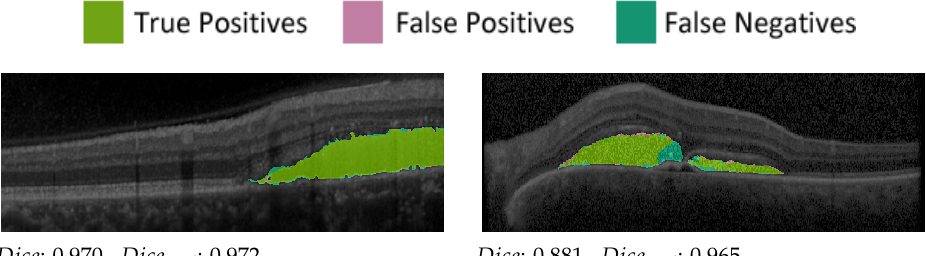
Figure 5. Two predictions and correspondingscores from the OCT evaluation